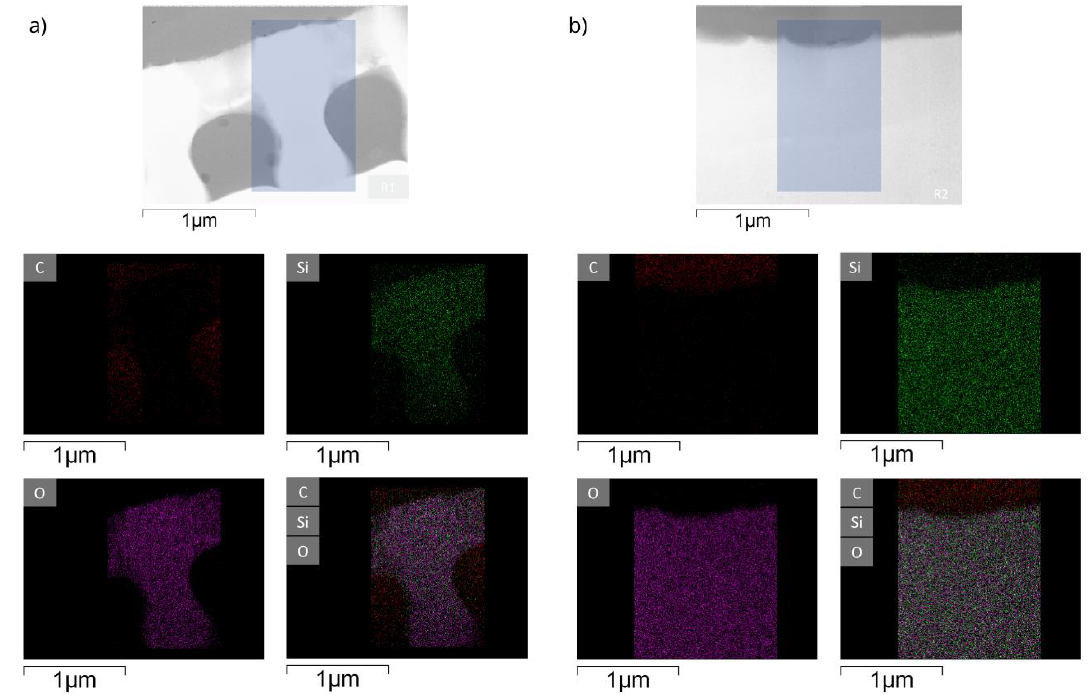
Figure 5. Energy-dispersive X-ray spectroscopy maps for carbon, oxygen and silicon of ( a ) internal ribs, and ( b ) central raphe of a Didymosphenia geminata frustule sample.